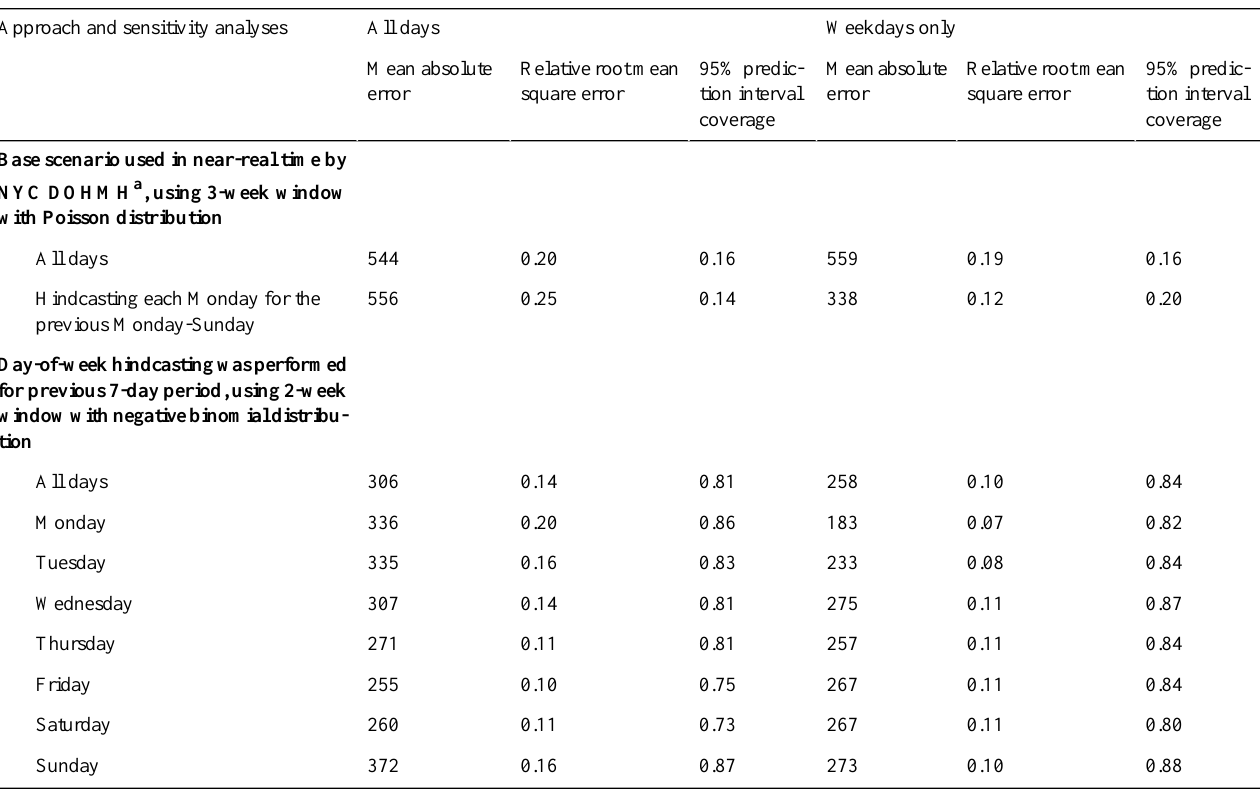
Table 1. Performance measures for hindcasting approaches applied to citywide case counts of New York City residents diagnosed with COVID-19, from March 22 to May 31, 2020.